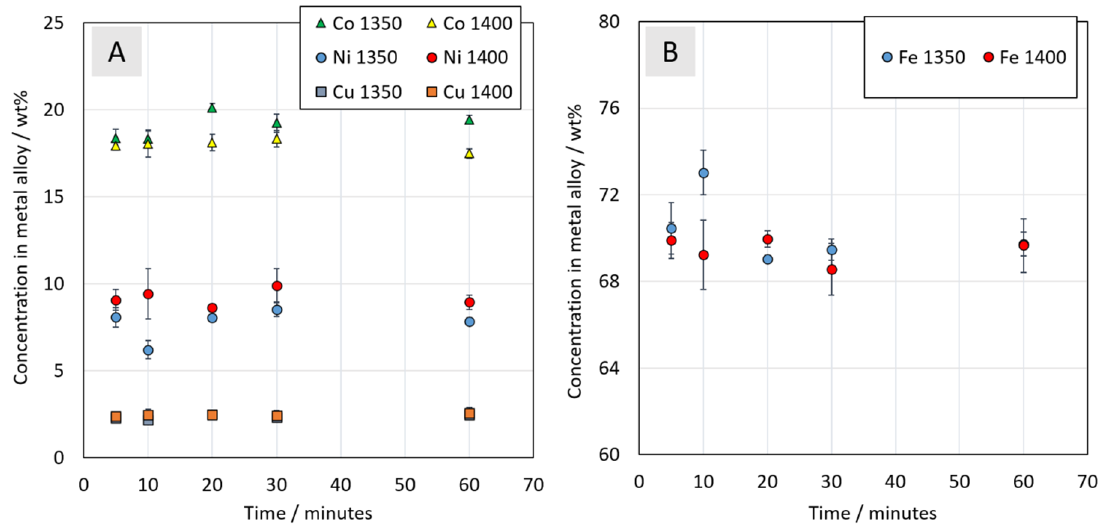
Figure 14. Concentrations of ( A ) cobalt, nickel, and copper and ( B ) iron in the metal alloy as a function of time in argon atmosphere.